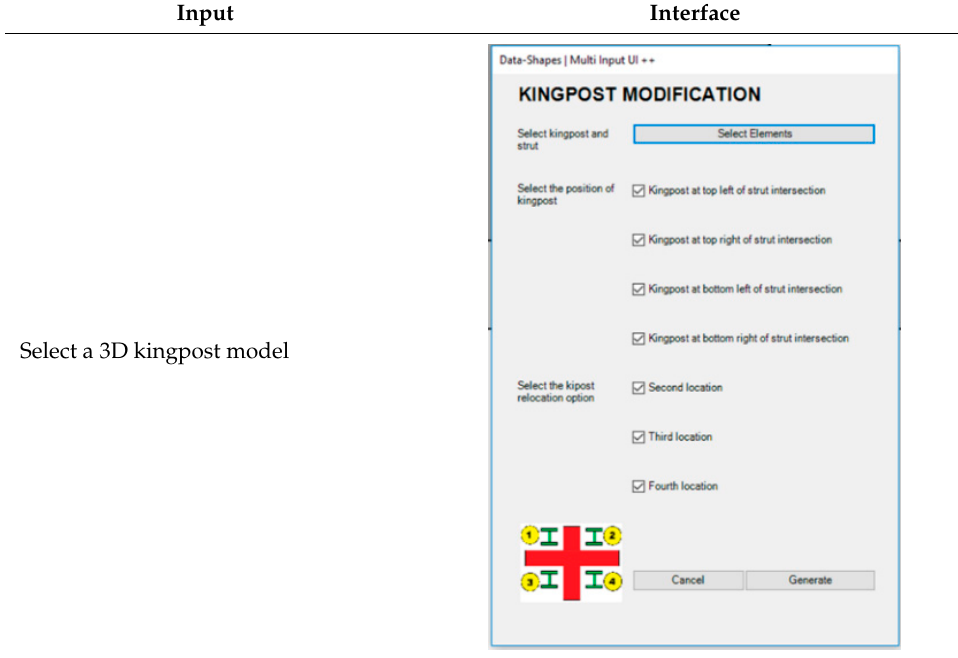
Figure 19. Clash detection of kingposts in a 3D environment.